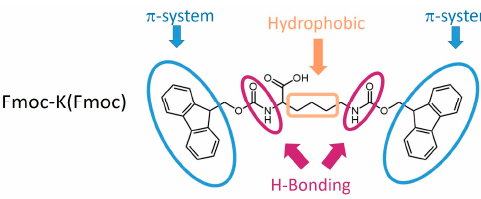
Figure 2. Chemical structure of the gelator Fmoc-K(Fmoc). The highlighted regions indicate the corresponding possible interactions during self-assembly.